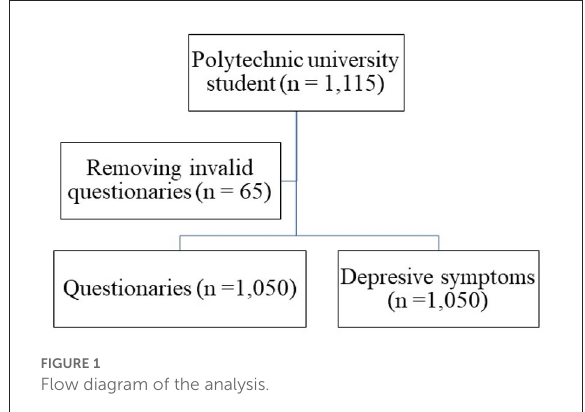
FIGURE1 Flow diagram of the analysis.